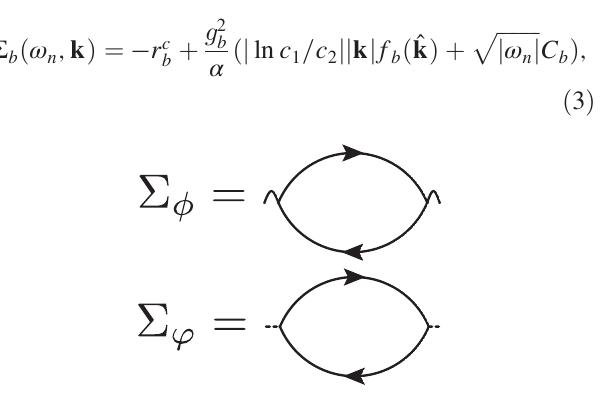
FIG. 4. 1 =N diagrams for the fermion self-energy Σ corrections Ξ ϕ and Ξ φ (only two-loop diagrams that need to be calculated, i.e., that do not vanish or cancel one another, are shown). Double lines indicate the renormalized boson propaga- tors including the self-energies from Fig. 3. Expressions for these diagrams are given in Appendix C